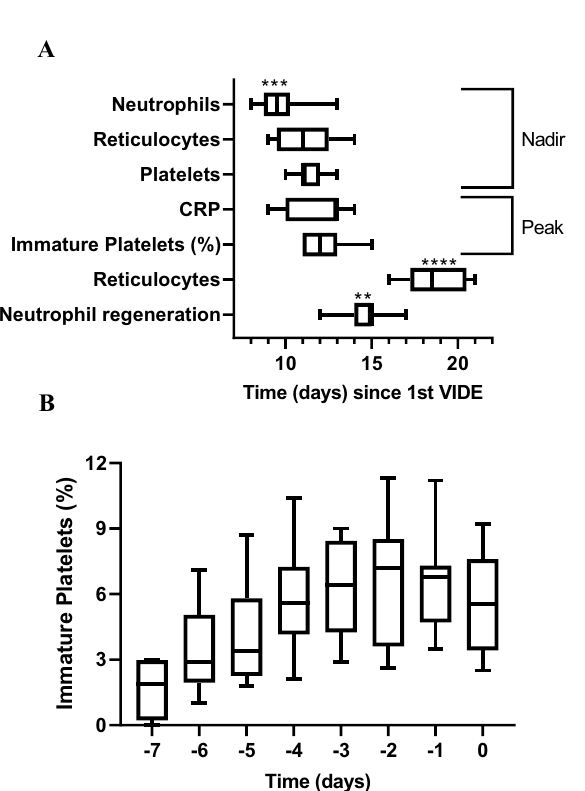
Figure 2. ( A ) Immature platelets (IPF%) have good potential for predicting reticulocyte (> 2‰, p < 0.0001) and neutrophil (> 0.1G/L, p = 0.0085) regeneration. The figure shows the nadir of neutrophils, reticulocytes, and platelets and the peak of CRP and IPF% after starting the first VIDE cycle (= day 0). The significant values relate to IPF%. ( B ) The IPF% peak occurs 2.4 days before regeneration of neutrophils (> 0.1G/L, day 0) and is 6.56% ± 2.8% (mean ±